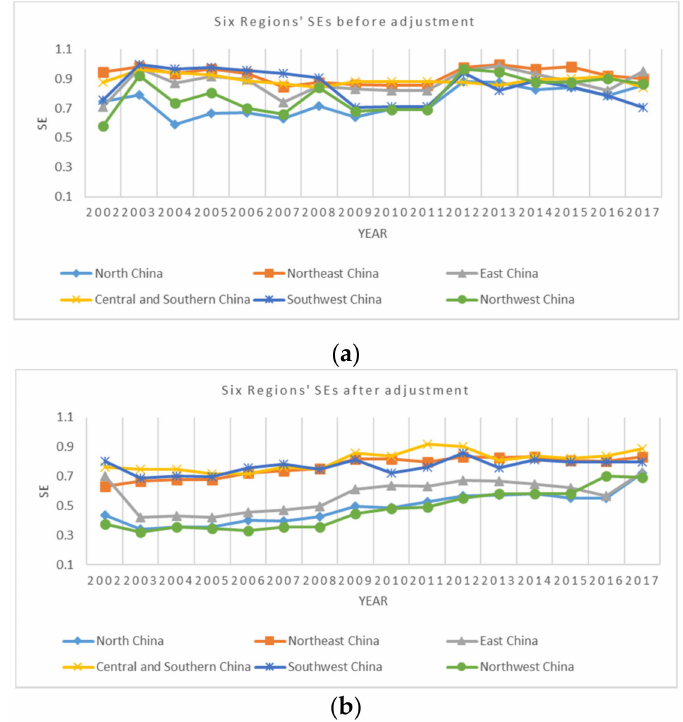
Figure 4. Six regions’ SEs over the study period before and after the